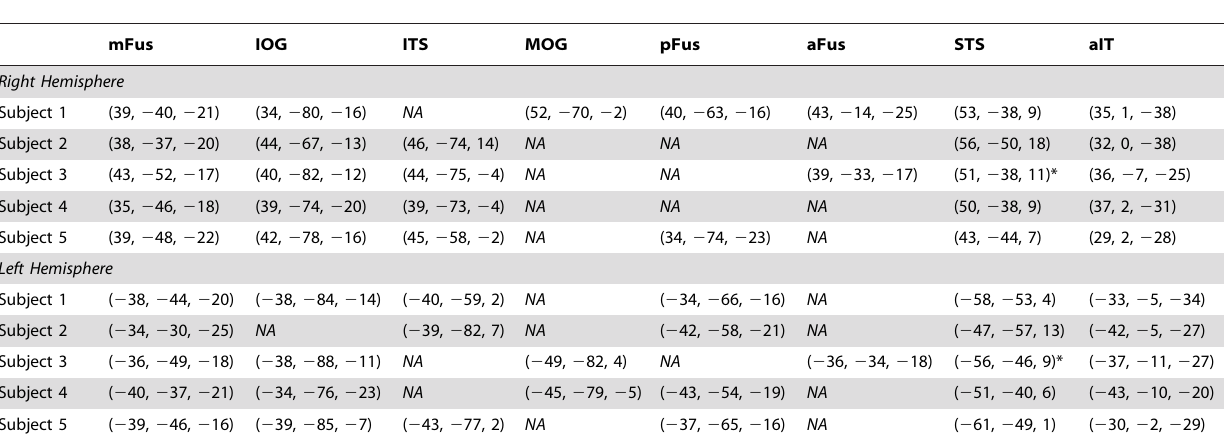
Table 1. Face Selective Regions Talairach Coordinates (x, y,